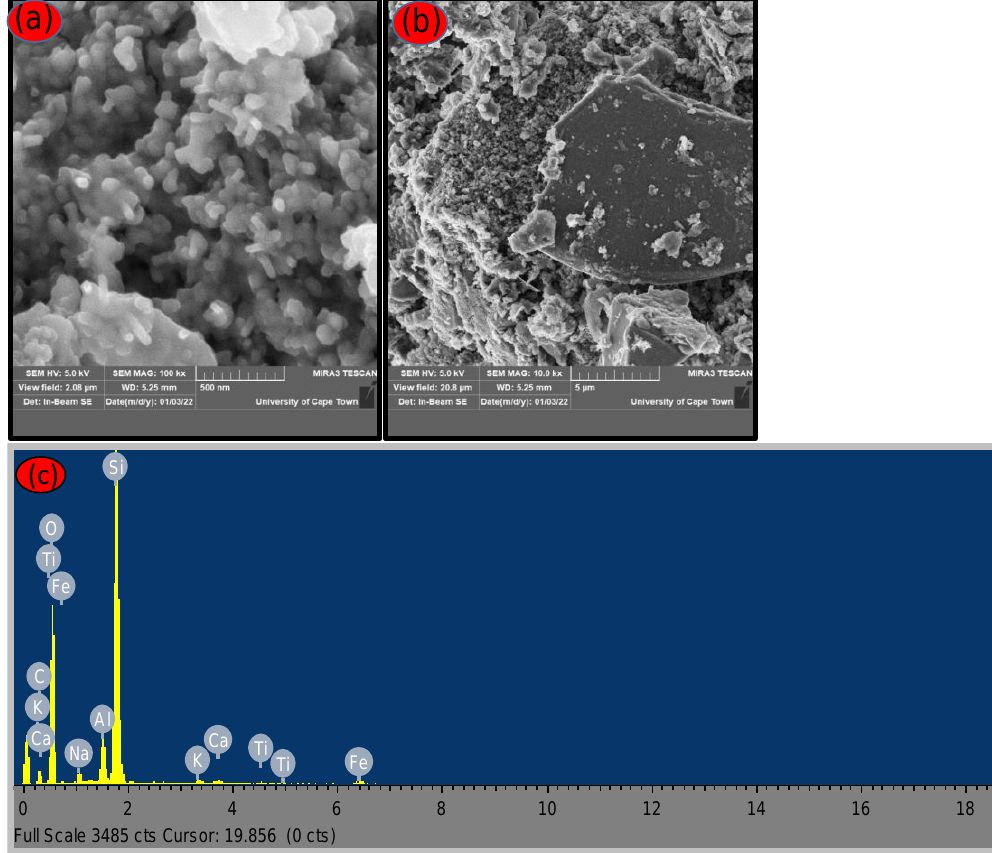
Figure 3. SEM images presentation of ( a ) leached silica (low magnification), ( b ) leached silica (high magnification) and ( c ) SEM-EDX of as-synthesized CA-TPAH silica treated with citric acid.